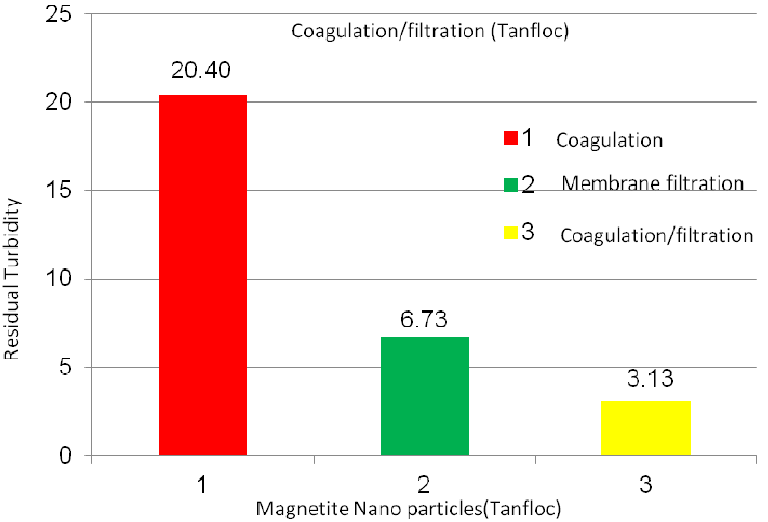
Figure 9. Turbidity values of magnetic nanoparticle suspensions using Tanfloc coagulation, membrane filtration, and coagulation + filtration processes; coagulation tests conducted using 5 mg/L Tanfloc after 24 h of settlement in